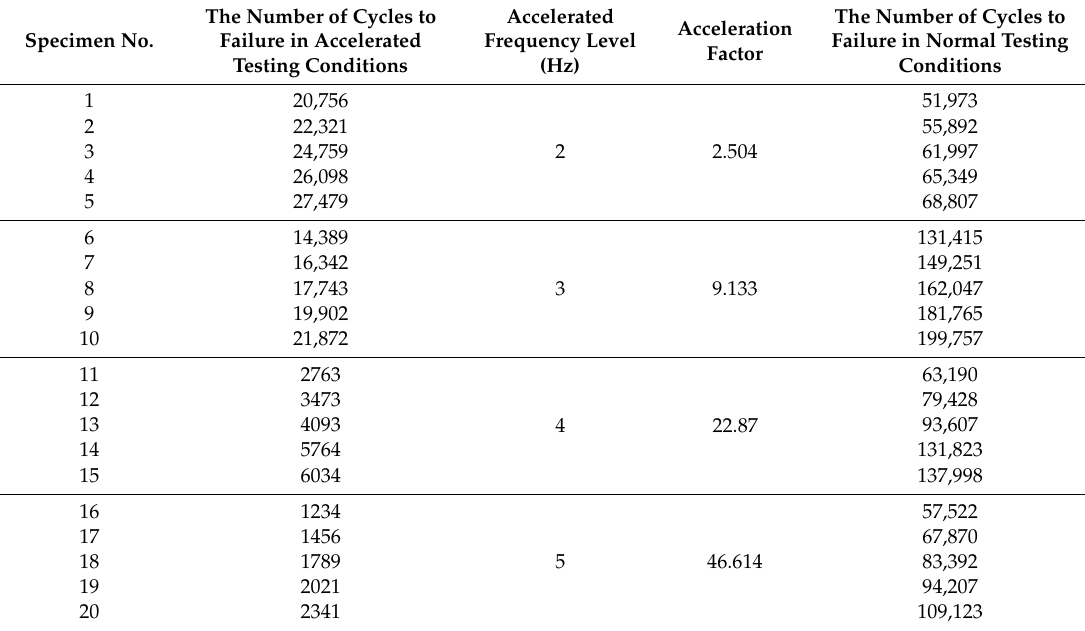
Table 4. Determination of the number of cycles to failure for normal testing conditions (1.5 Hz loading frequency) of GFRP-foam specimens.